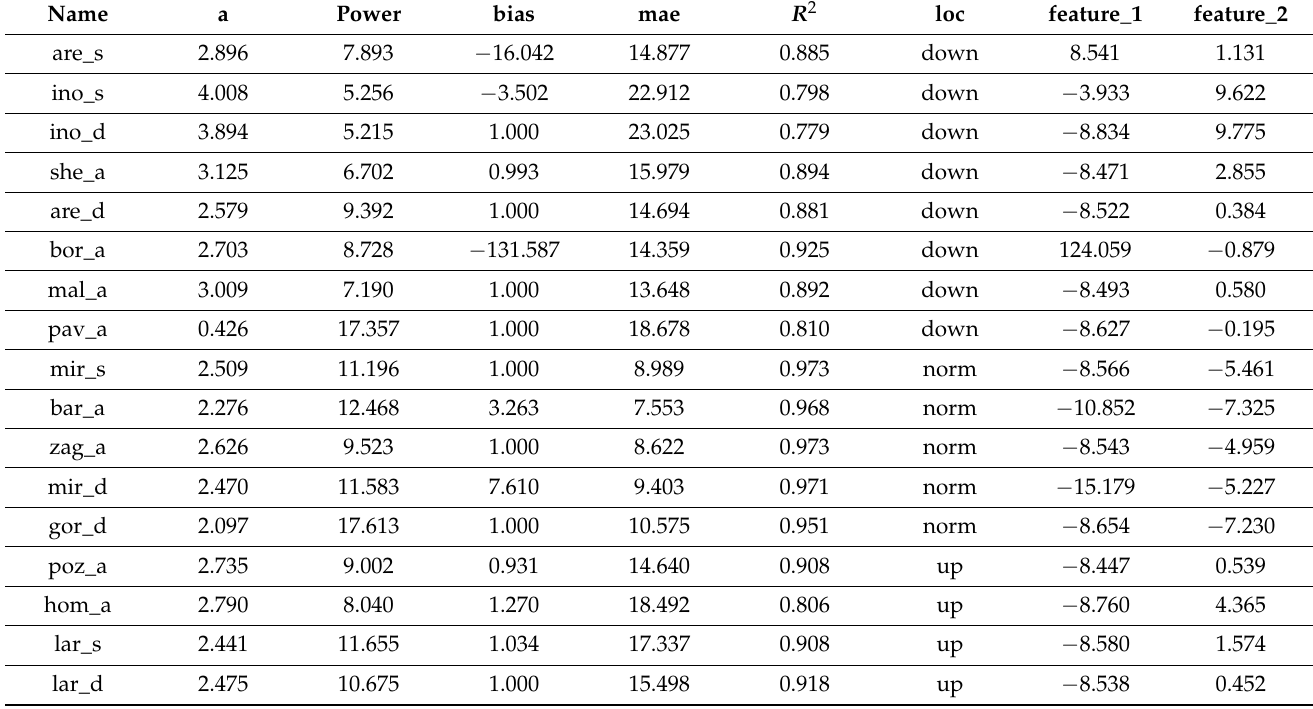
Table 2. Comparison of the geometric characteristics of the approximation of the central line of the